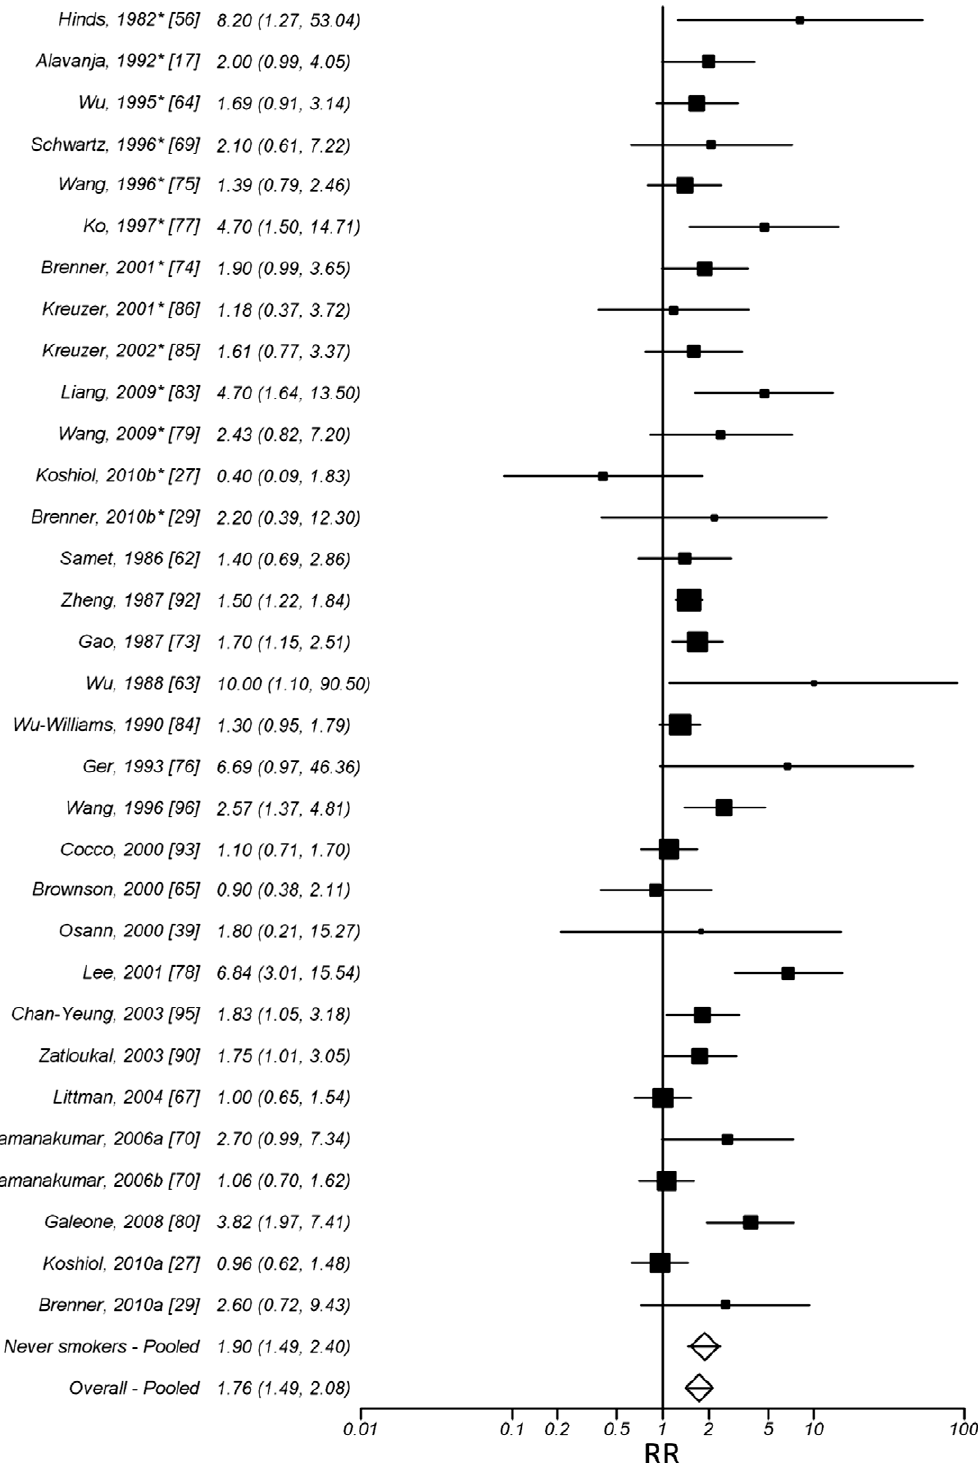
Figure 3. Pooled estimates of the risk associated with a previous diagnosis of tuberculosis, separated by smoking status (never smokers on top, smokers on bottom) and overall. * Studies of never smokers.The pooled RR were estimated from random effects models. The study by Ger 1993 [76] represents only the estimate using population controls was included. The study labeled Ramanakumar, 2006a [70] represents the estimates for one population in study using population controls (cancer controls not included), the studies labeled Ramanakumar, 2006b [70] represents the estimates for the second population in the manuscript study [70] combined among males and females (no combined estimate originally provided). The study by Chan-Yeung, 2003 [90] represents the estimate combined among males and females (no combined estimate originally provided). The studies noted with a b* represent the estimates from a subgroup of never smokers presented in the manuscript which were not included in the overall estimates.